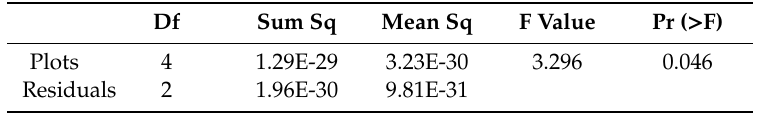
Table 6. Analysis of variance of the coverage of dead woody components of the five plots of the study